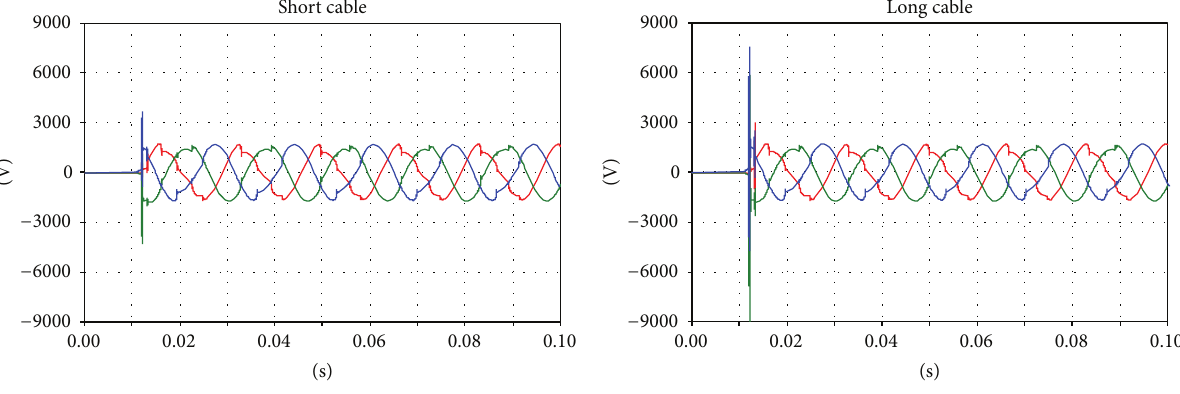
Figure 16: The secondary side voltages during the inrush.